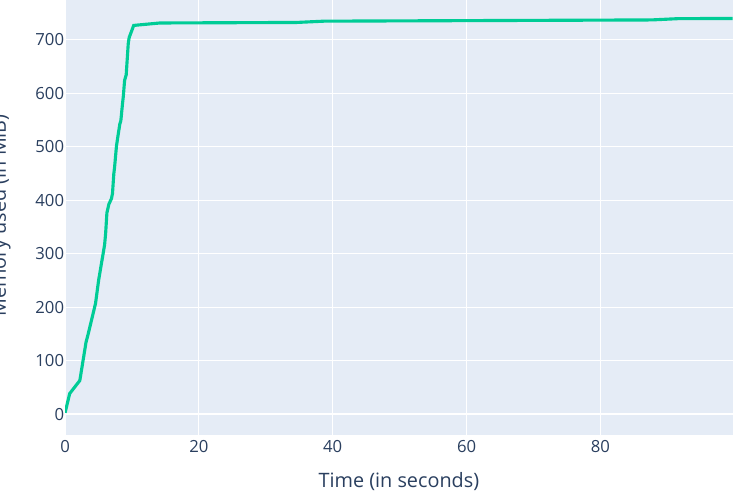
Figure 5. Memory consumption of the Aurora client in light mode measured with memory-profiler for Python.